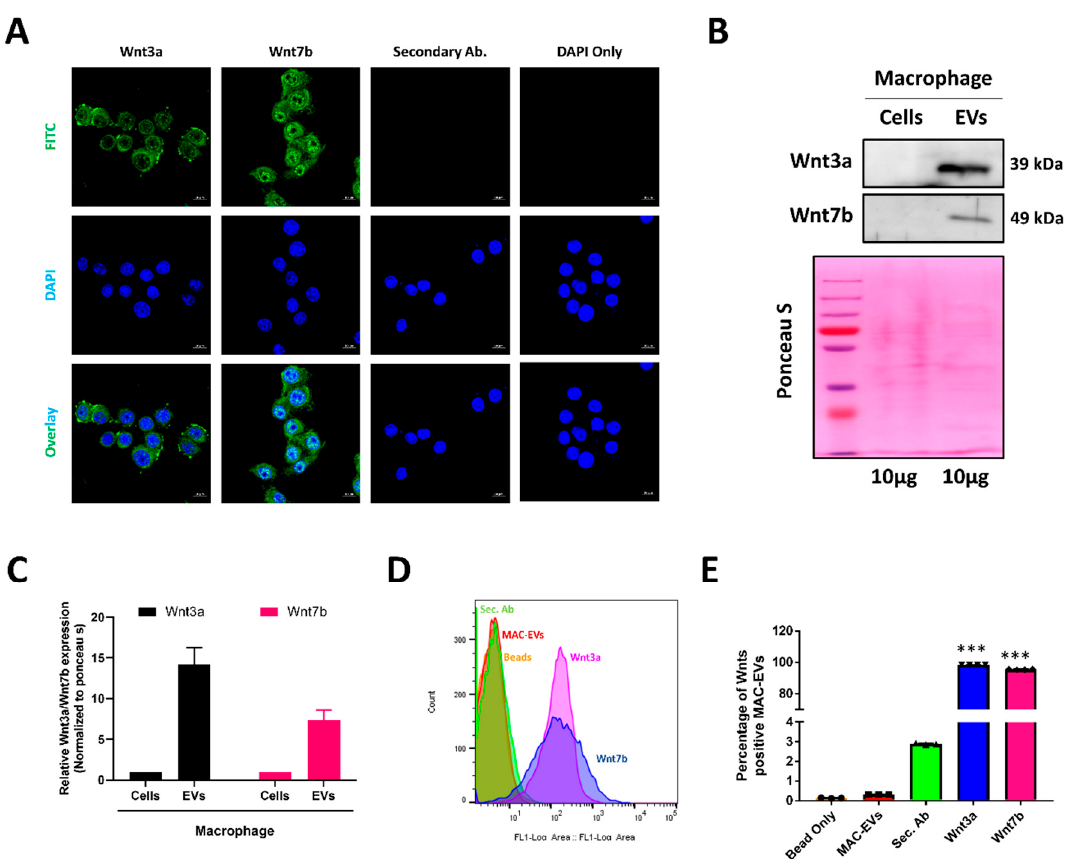
Figure 2. Identification of Wnt3a / Wnt7b protein in MAC-EVs and its association with their membranes. ( A ) Immunofluorescent assay of Wnt3a / Wnt7b in macrophages (scale bar: 10 µ m). ( B ) Western blot analysis of Wnt3a and Wnt7b in macrophages (Cell) and MAC-EVs (EV). Ponceau S staining used as loading control. ( C ) Quantification (fold) of Wnt3a and Wnt7b in macrophages (Cell) and MAC-EVs (EV) ( n = 3). ( D ) Representative flow cytometry count graph of beads only, Control (MAC-EVs), Control (Secondary FITC Antibody), Wnt3a and Wnt7b. ( E ) Percentage of Wnt3a and Wnt7b positive MAC-EVs ( n = 4) from total population. Means ± standard deviation (SD) of experiments are shown. *** p < 0.001. Student’s t-test was used for comparison. EV: Extracellular Vesicles.